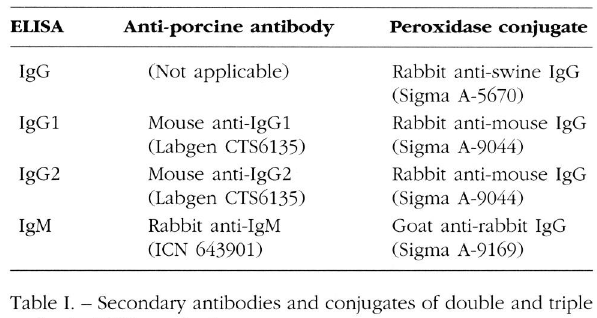
Table I. - Secondary antibodies and conjugates of double and triple antibody ELISA